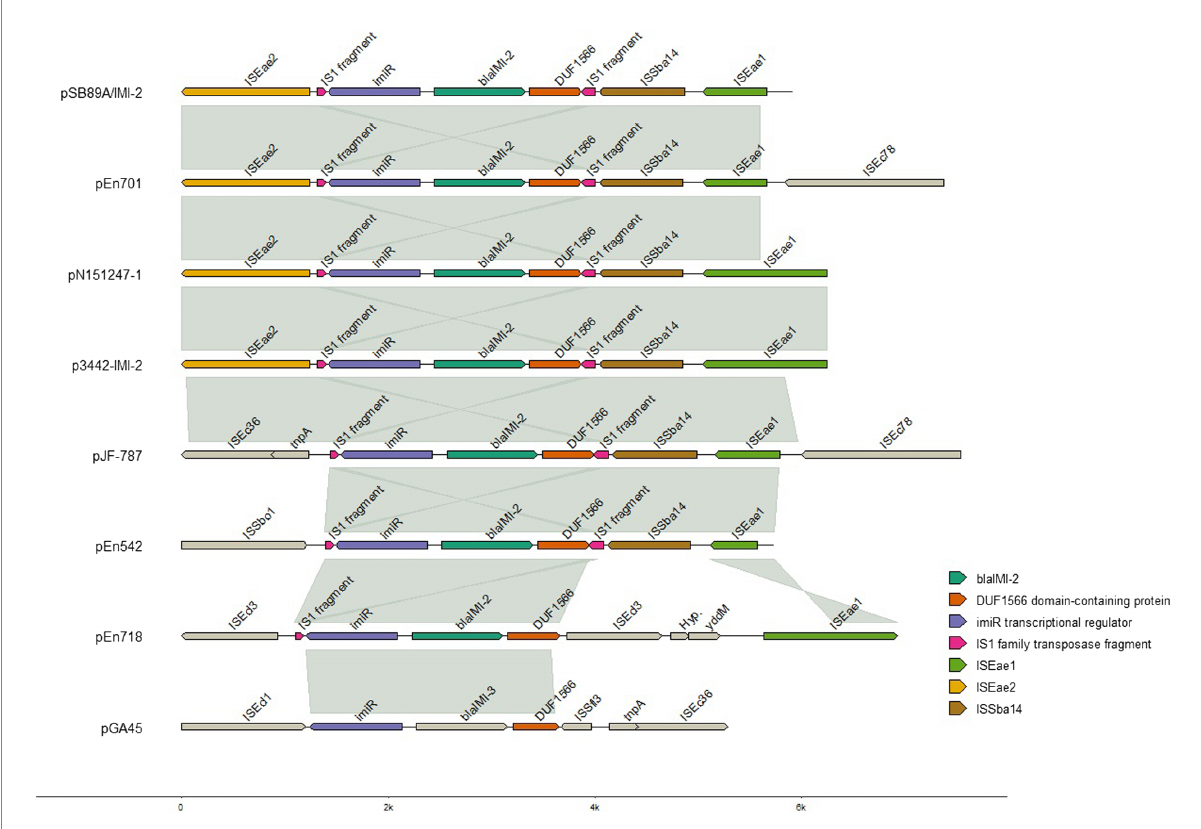
FIGURE 2 Alignment of bla IMI-2 genes and adjacent insertion elements. The aligned segments connected with gray lines shows 96.98–99.98% sequence identity, with the exception of p3442-IMI-2 and pJF-787 which showed 92.1% sequence identity. Figure created with genomes in R. For visualization purposes the sequences of pSB89A/IMI-2, pN151247-1 and p3442-IMI-2 have been inverted. The pGAA45 which carries a bla IMI-3 gene is also included for comparisons, as for the pSB89A/IMI-2, pN151247-1 and p3442-IMI-2 the sequence of pGAA45 have been